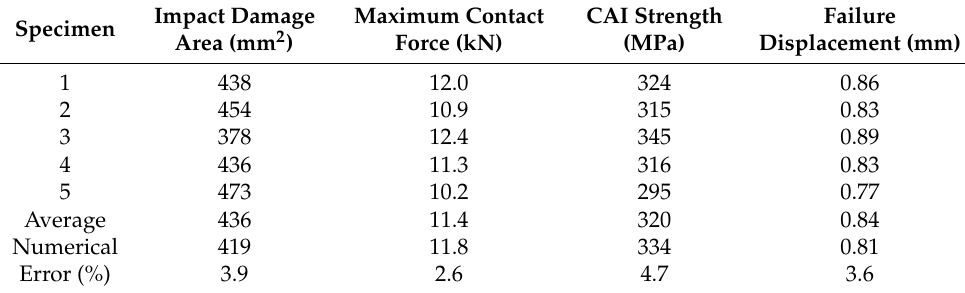
Table 2. Damage areas and CAI specimens of the specimens. Figure 3. Contact forces and damage areas of specimens. ( a ) Comparison of the contact force during impact. ( b ) Relationship between damage area and contact force.